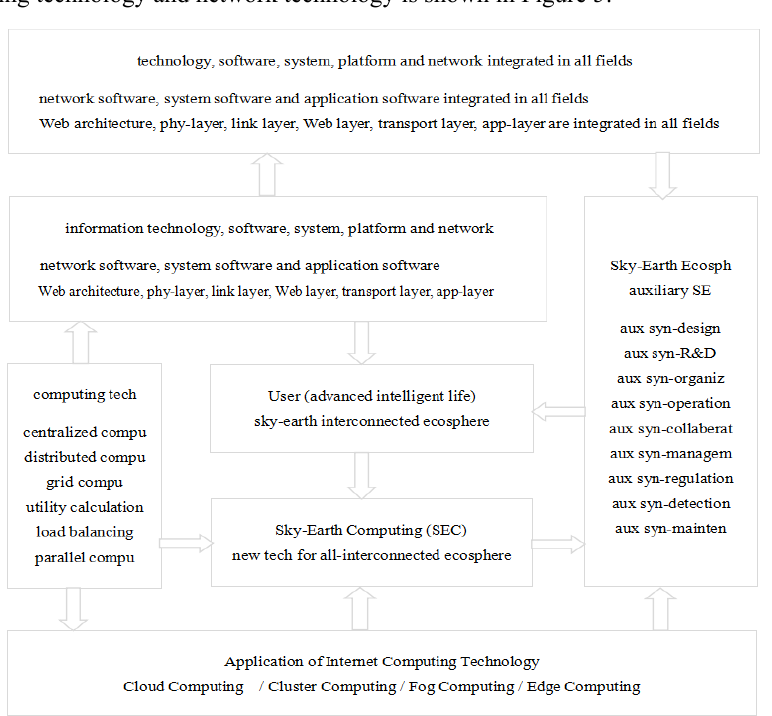
Fig. 5. Sky-earth computing system engineering supported by information technology, computing technology and network